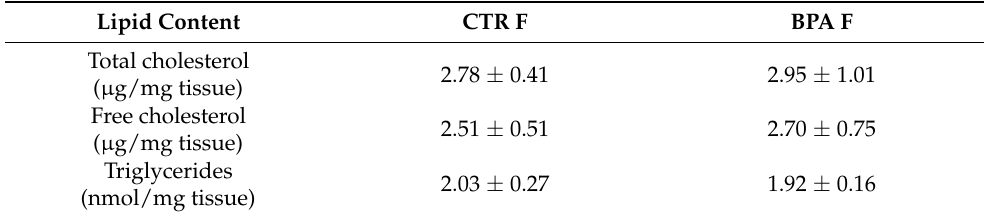
Table 2. Effects of prenatal exposition to 2.5 µ g/kg/day of BPA on hepatic cholesterol and triglyc- erides content in female fetus rats. Total cholesterol, free cholesterol, and triglycerides were measure in liver of female fetuses (CTR F = female control; BPA F = female exposed to BPA) n = 6 for each experimental group. Differences between groups were considered as significant at p < 0.05 and were analyzed with unpaired Student’s t test.